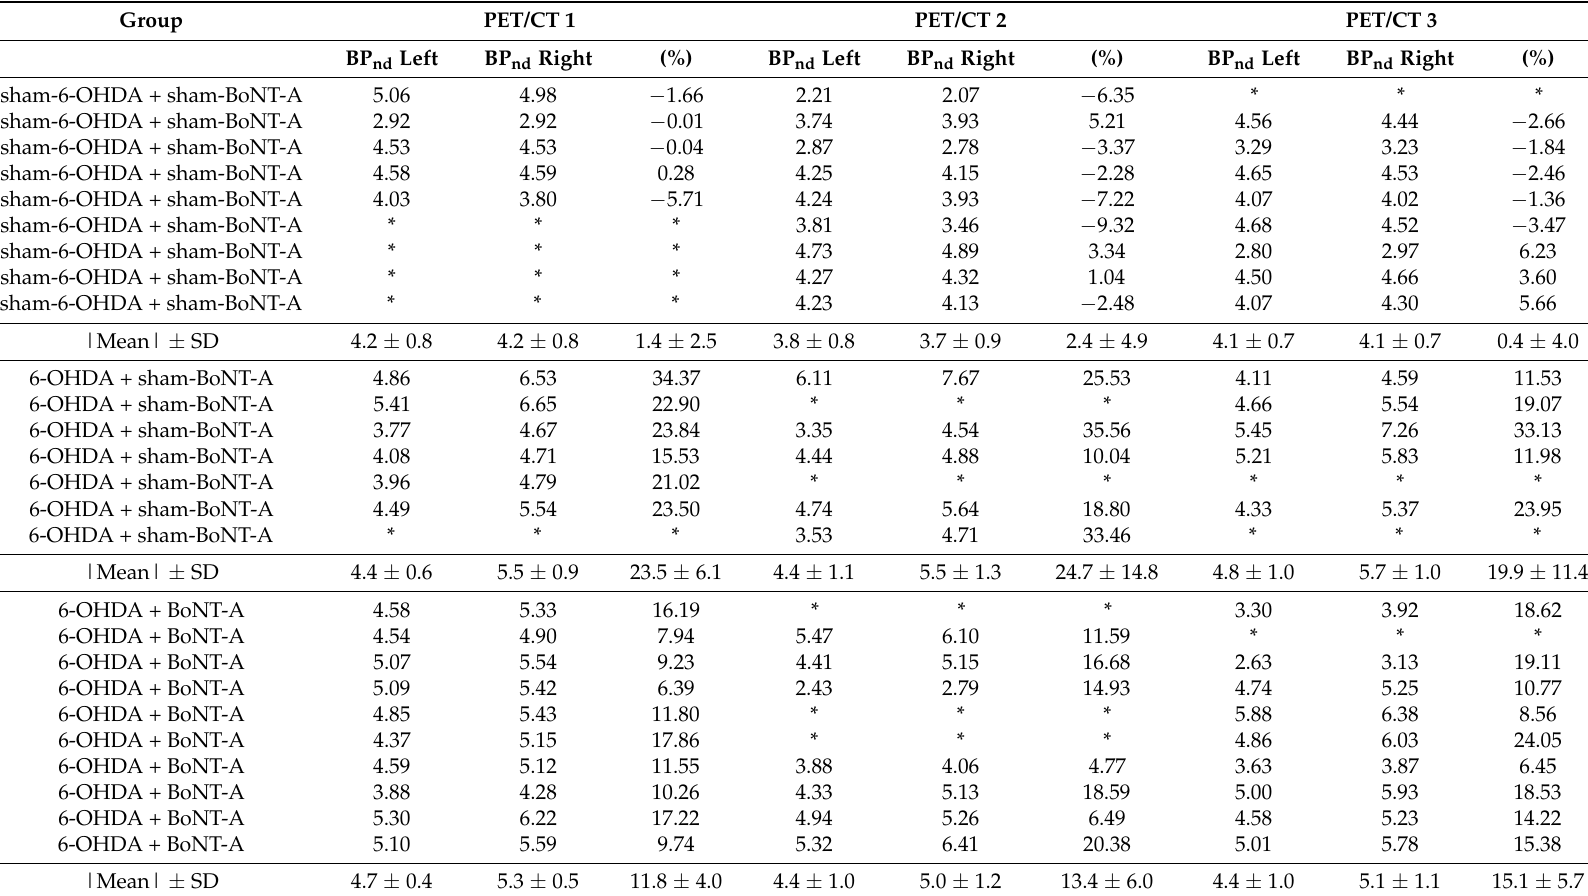
Table 1. Summary of all single BP nd values of D 2 /D 3 R for the left and right CPu and the interhemispheric difference relative to the left hemisphere in (%) analyzed in controls (sham-6-OHDA + sham-BoNT-A), sham-injected hemi-PD rats (6-OHDA + sham-BoNT-A) and BoNT-A-injected hemi-PD rats (6-OHDA + BoNT-A). Data are shown for all three PET/CT scans (PET/CT 1: one month post-BoNT-A or sham-BoNT-A, PET/CT 2: three months post-BoNT-A or -sham-BoNT-A, PET/CT 3: six months post-BoNT-A or -sham-BoNT-A). * indicate that no data were analyzed due to incorrect tracer injection or no data acquisition.